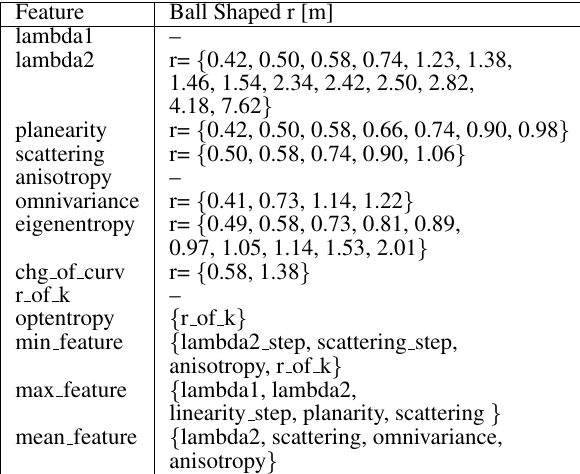
Table 2. CFS Selected Features - Ball Shaped